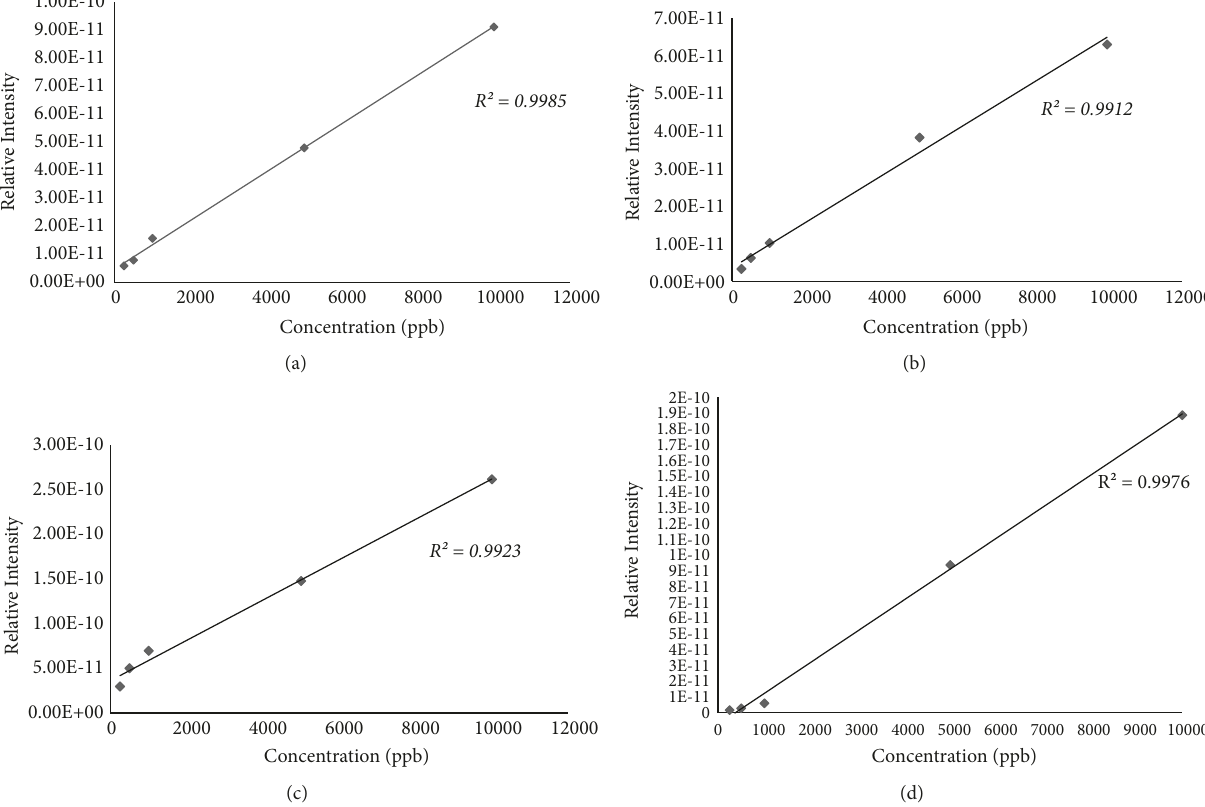
Figure 3: Calibration curve for the standard model compounds using various concentration (250 – 10000 ppb) samples of (a) 2-methyl-3- furanthiol (Mw 114), (b) methyl butanoate (Mw 102), (c) ethyl methyl sulfide (Mw 76), and (d) 3-methylbutyl acetate (Mw 130 obtained from the portable mass spectrometer with a DIM